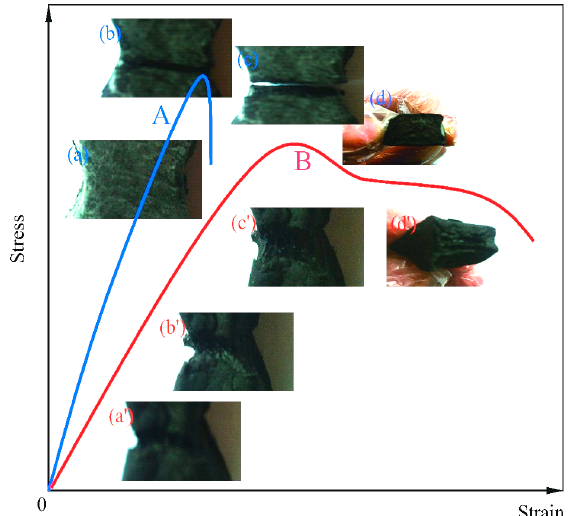
Figure 12. Tension fracture of microcapsules/bitumen samples: Images of bitumen samples broken process using a displacement speed of 100 mm·min − 1 at 0 °C, ( a – d ) the pure bitumen (40/50), ( a ’– d ’) the re-fracture of the same sample of bitumen (40/50) mixing with microcapsules (20 μ m, 3.0 wt. %): A and B are the strain-stress curves.